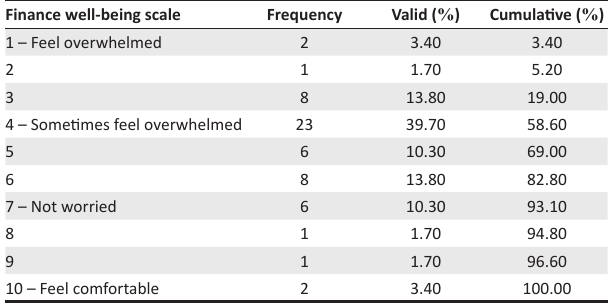
TABLE 3: How do you feel about your current financial condition? Finance well-being scale